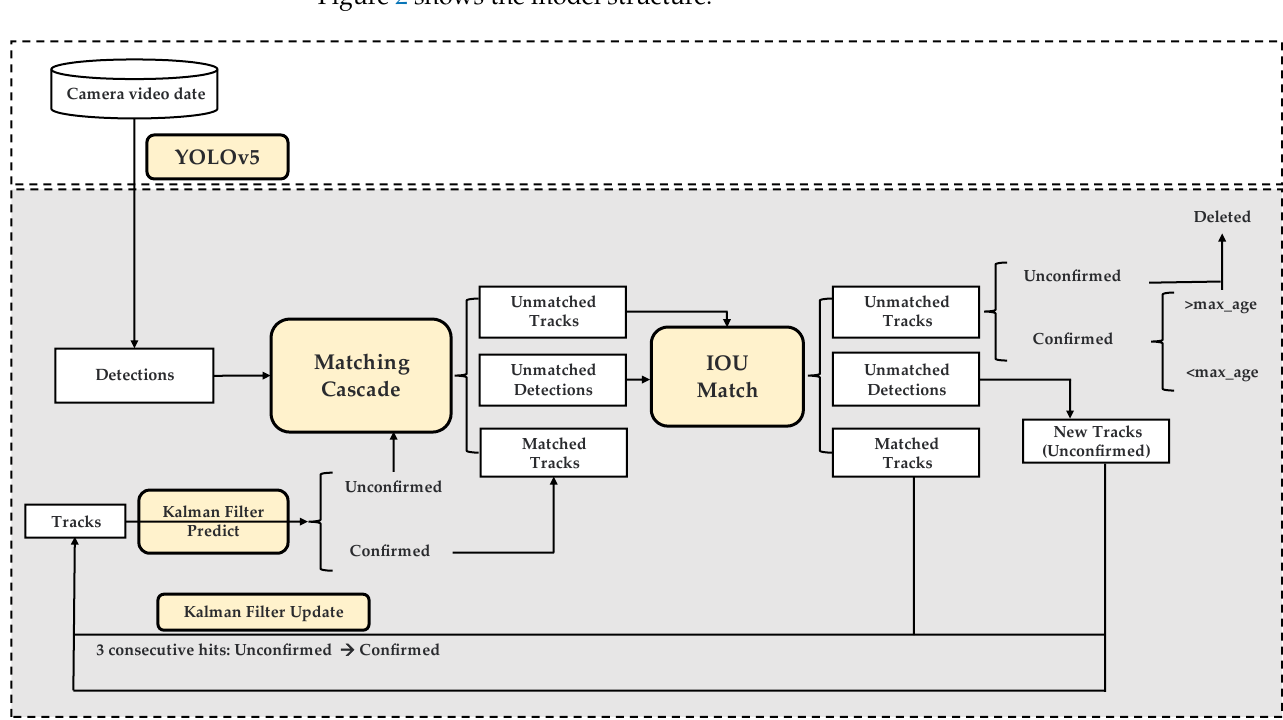
Figure 2. The structure of the single-region video trajectory extraction module.